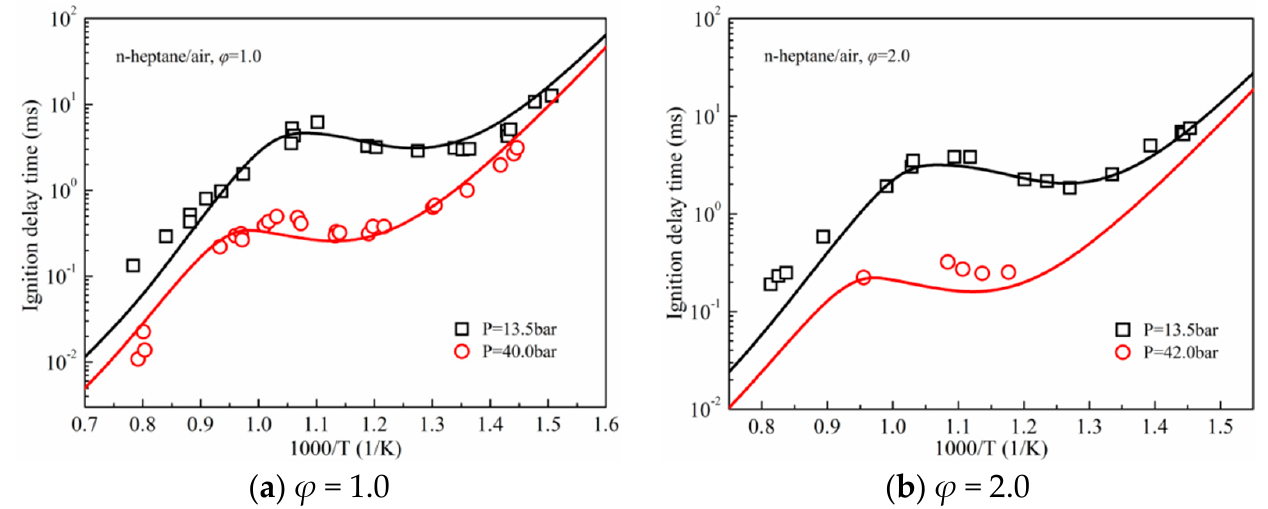
Figure 2. Comparisons between the predicted (lines) and experimental [37,38] (symbols) ignition delays of n-heptane/air mixtures.